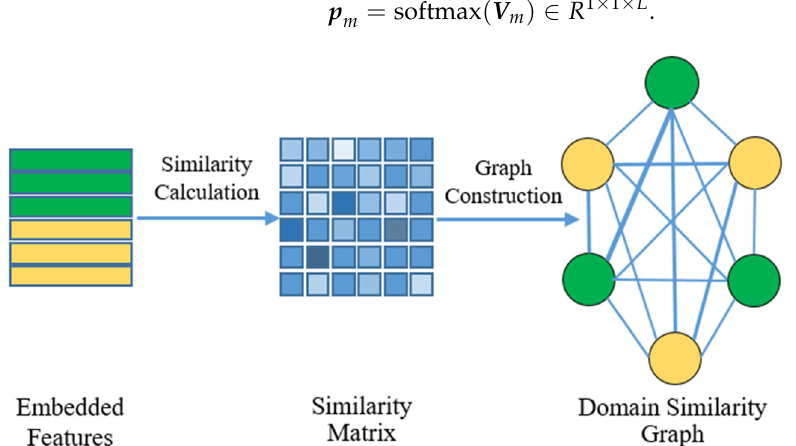
Figure 7. Illustration of GCM used in GDAN. The nodes with different colors denote samples of different domains. Lines of different thicknesses represent different sizes and values of edge weights.